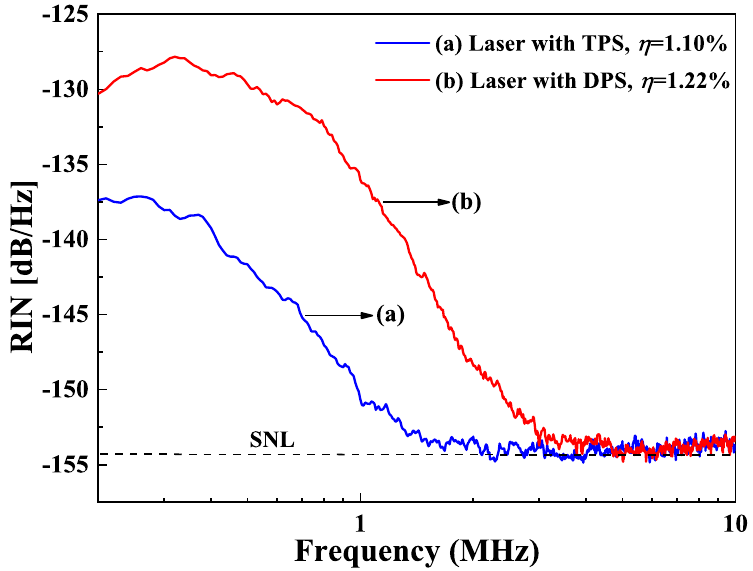
Figure 23. Intensity noise spectra of the single-frequency laser with the nonlinear loss [32]. Reprinted with permission from [32] c (cid:13) The Optical